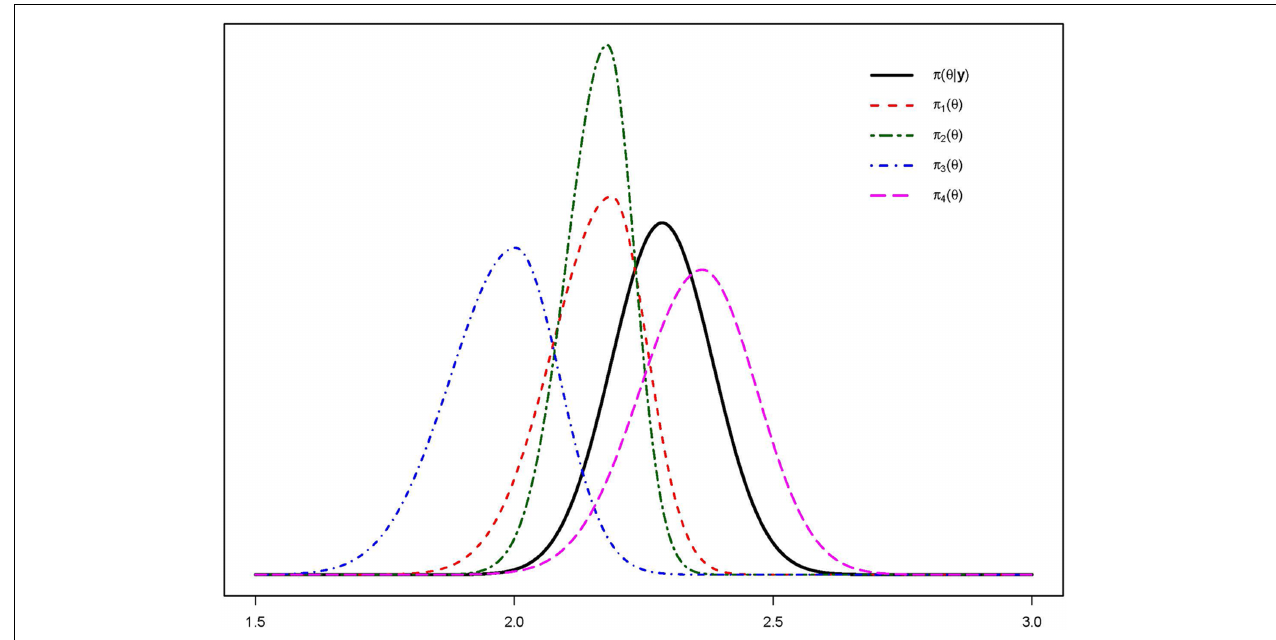
FIGURE 5 | Results Five-Step Method elicitation study with large financial institution. Elicited expert distributions π d ( θ ) plotted with results π ( θ | y ) .